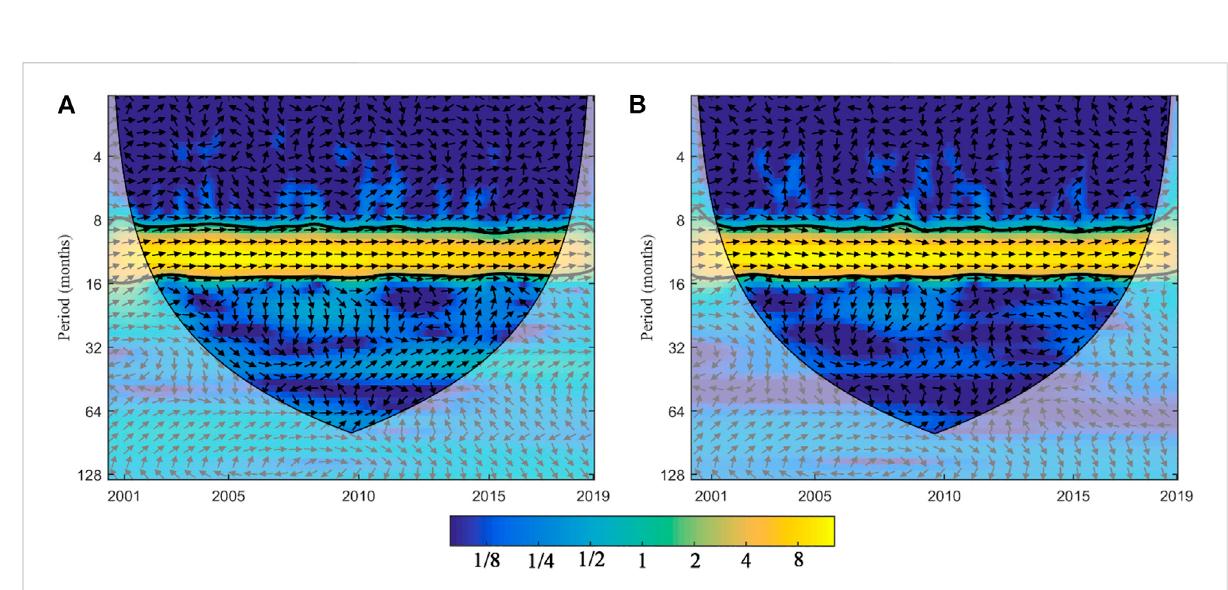
FIGURE 8 The cross wavelet transforms between meteorological and vegetation factors in the PRB: (A) NDVI and SPI5; (B) SIF and SPI3.